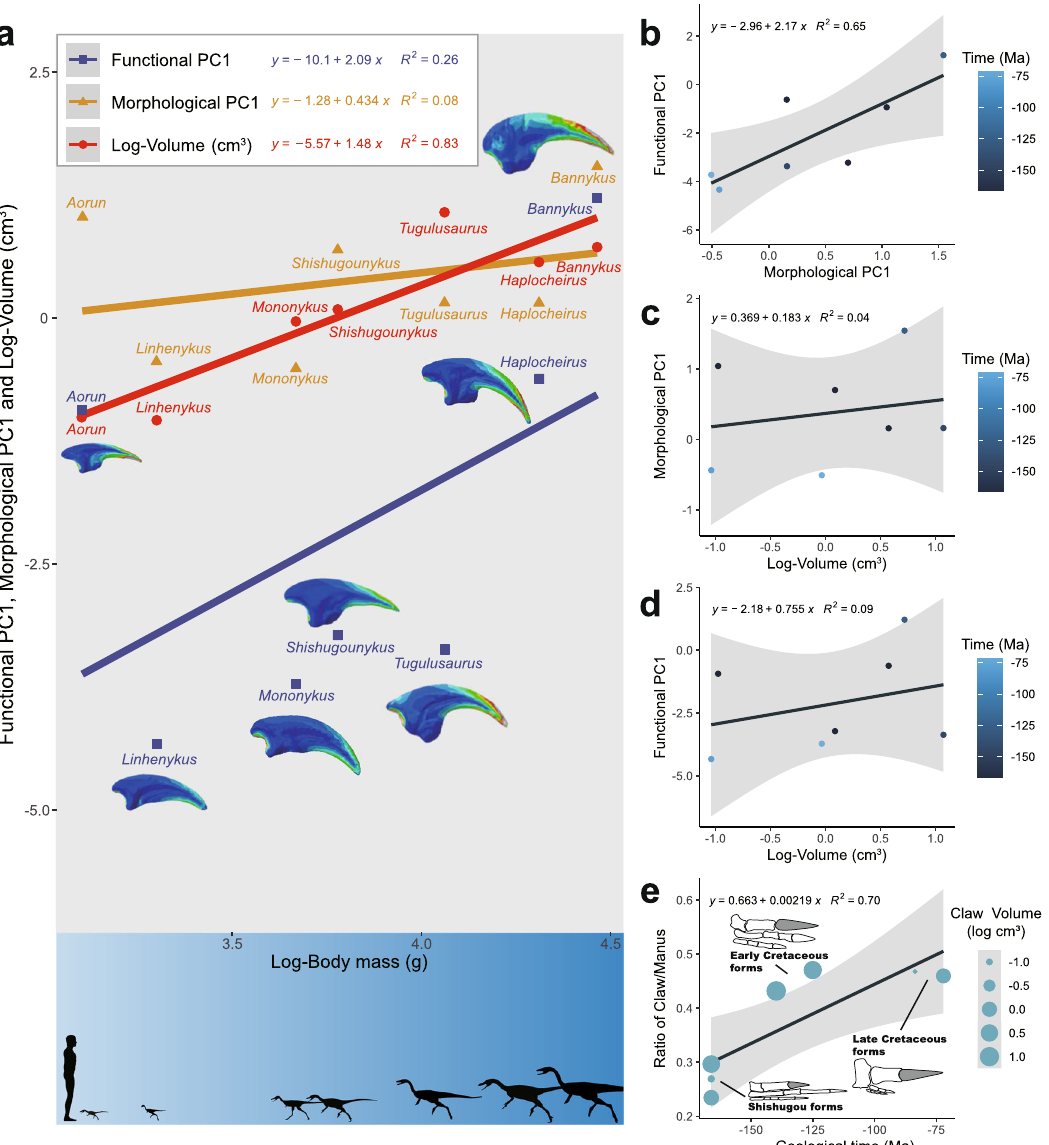
Fig. 6 Linear regressions of average functional performance, morphologies, and ungual size vs. body size of alvarezsauroids. ( a ) a good regression relationship only to the ungual sizes ( R 2 = 0.83, P value = 0.005 < 0.05). Linear regressions of functional divergences vs. morphological divergences ( b ), morphological divergences vs. log-transformed ungual volume ( c ), functional divergences vs log-transformed ungual volume ( d ) and proportion of length of unguals to the manus through geological time ( e ), showing close relationship between functional and morphological divergences ( R 2 = 0.65, P value = 0.029 < 0.05), but failing to support a strong relationship between functional performance and morphological specialisations to ungual volumes ( R 2 = 0.04, P value = 0.071 > 0.05; R 2 = 0.09, P value = 0.510 > 0.05), and higher proportion of manual unguals in late-branching alvarezsauroids ( R 2 = 0.70, P value = 0.019 <